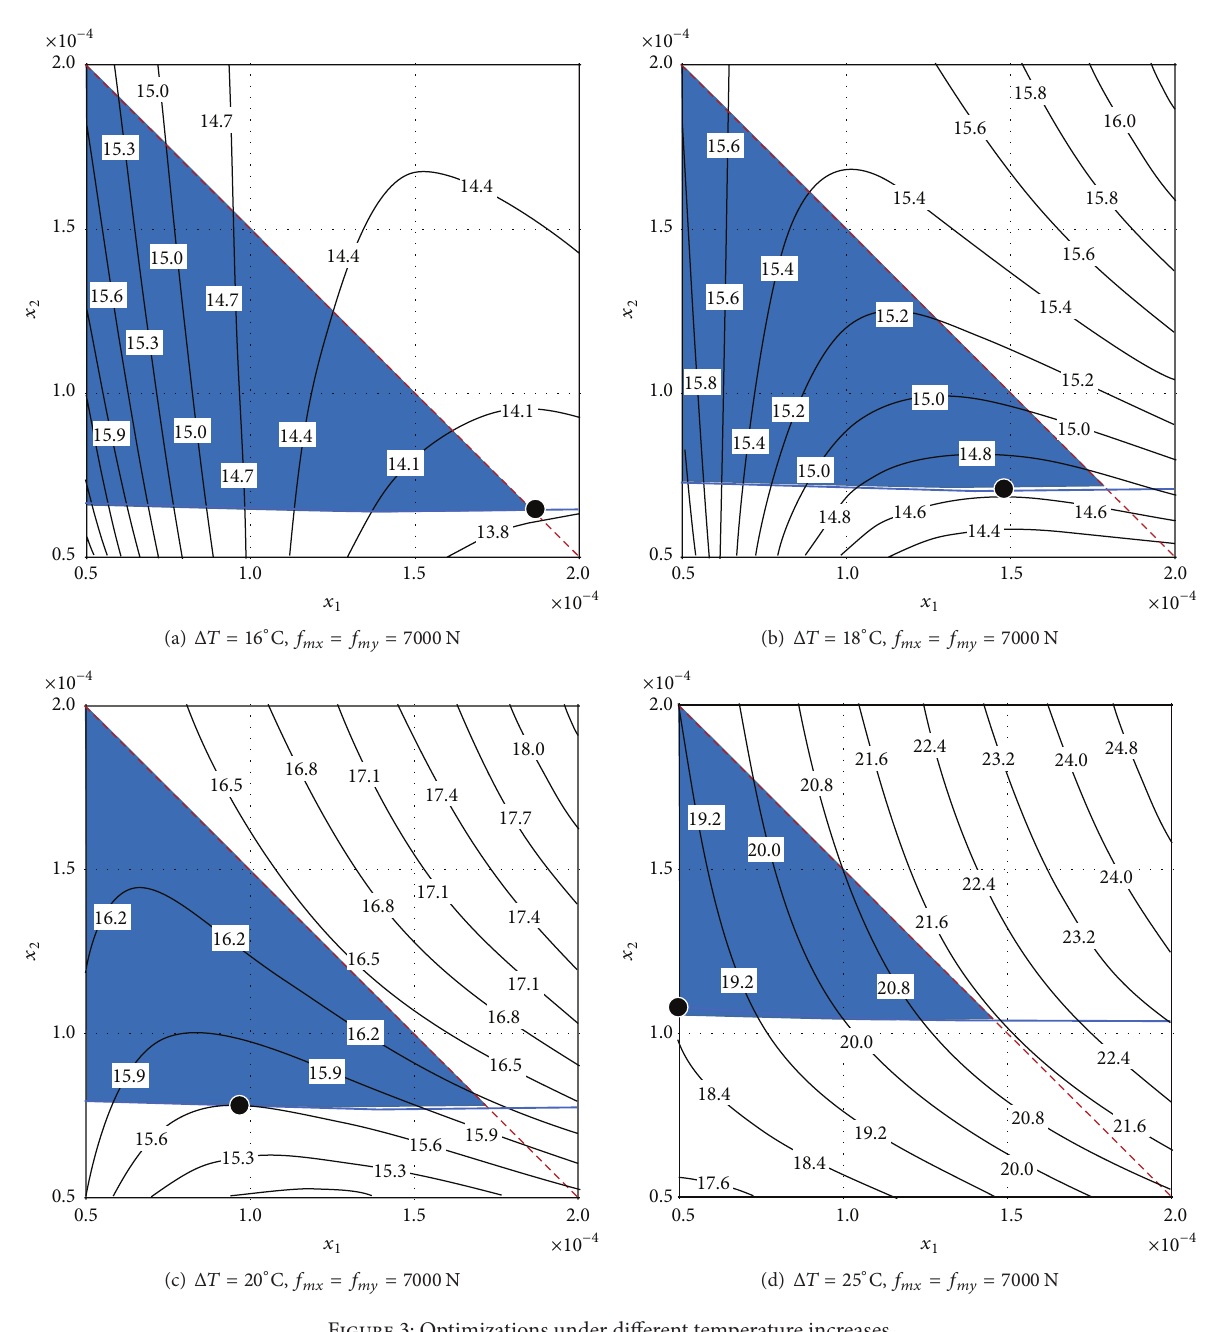
Figure 3: Optimizations under different temperature